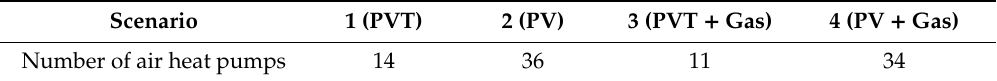
Table 8. Number of air heat pumps depending on the